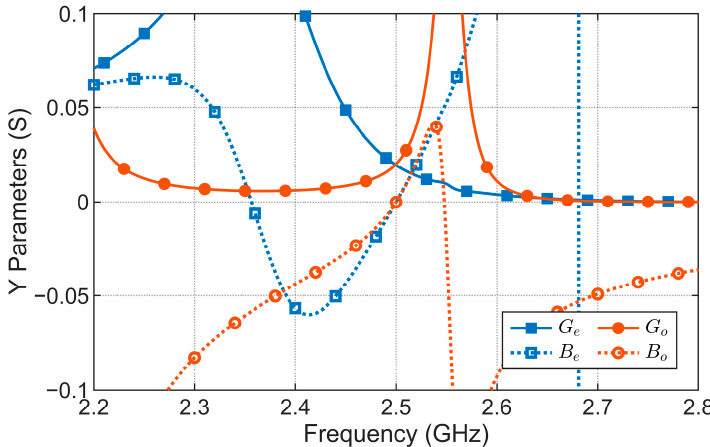
Figure 9. The even and odd admittances at reference plane t 3